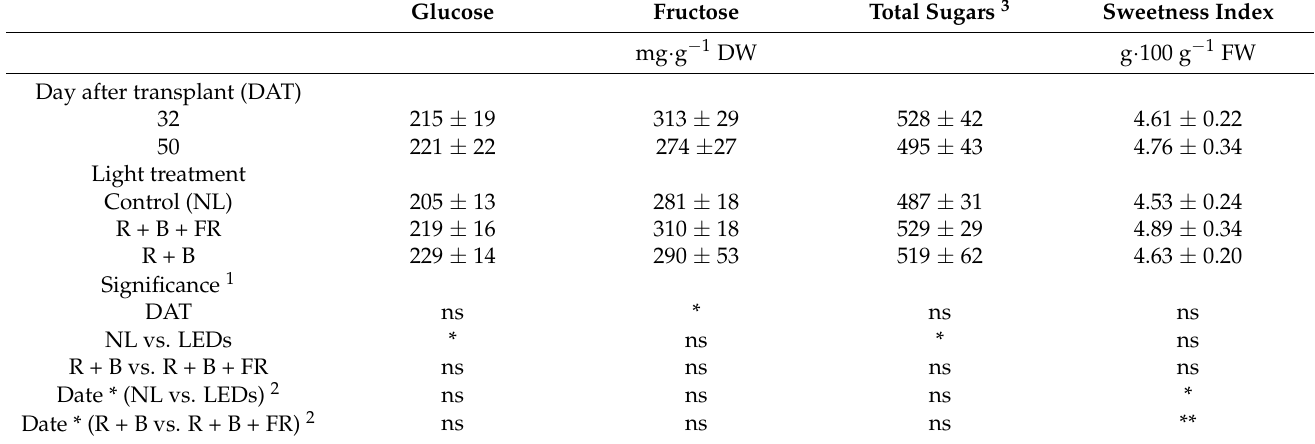
Table 4. S ugar content of the fruits of a landrace of Cucumis melo L. (“Carosello leccese”) in fruits from plants grown under solar light and two different light spectra. Values are average ± SD of three replications.